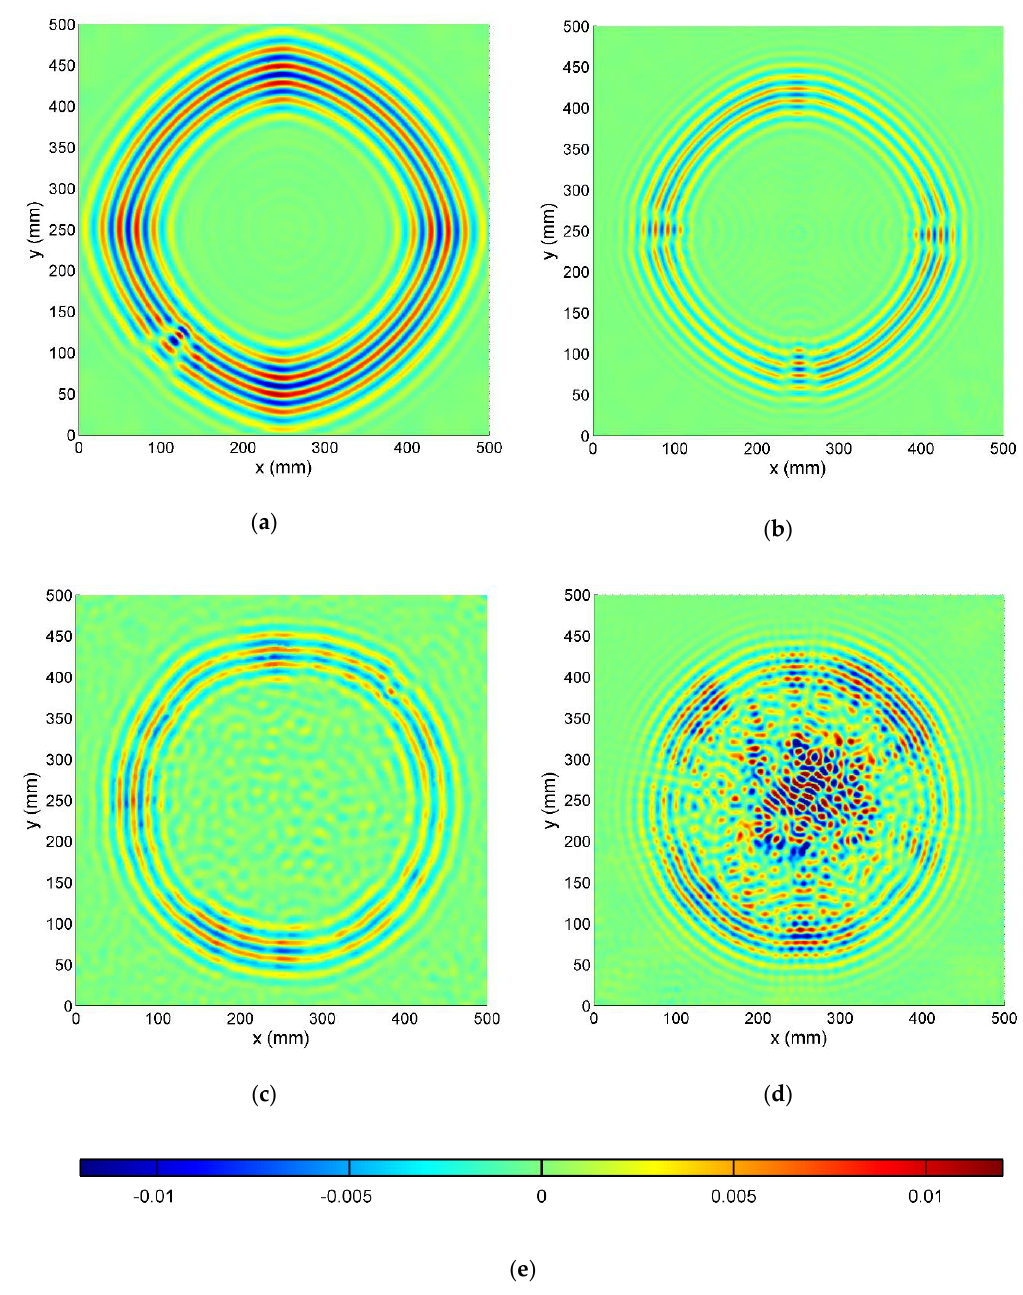
Figure 6. Wave images obtained at t = 200 µ s for: ( a ) CFRP; ( b ) GFRP; ( c ); SFRP ( d ); HCSP specimens; ( e ) Color scale.